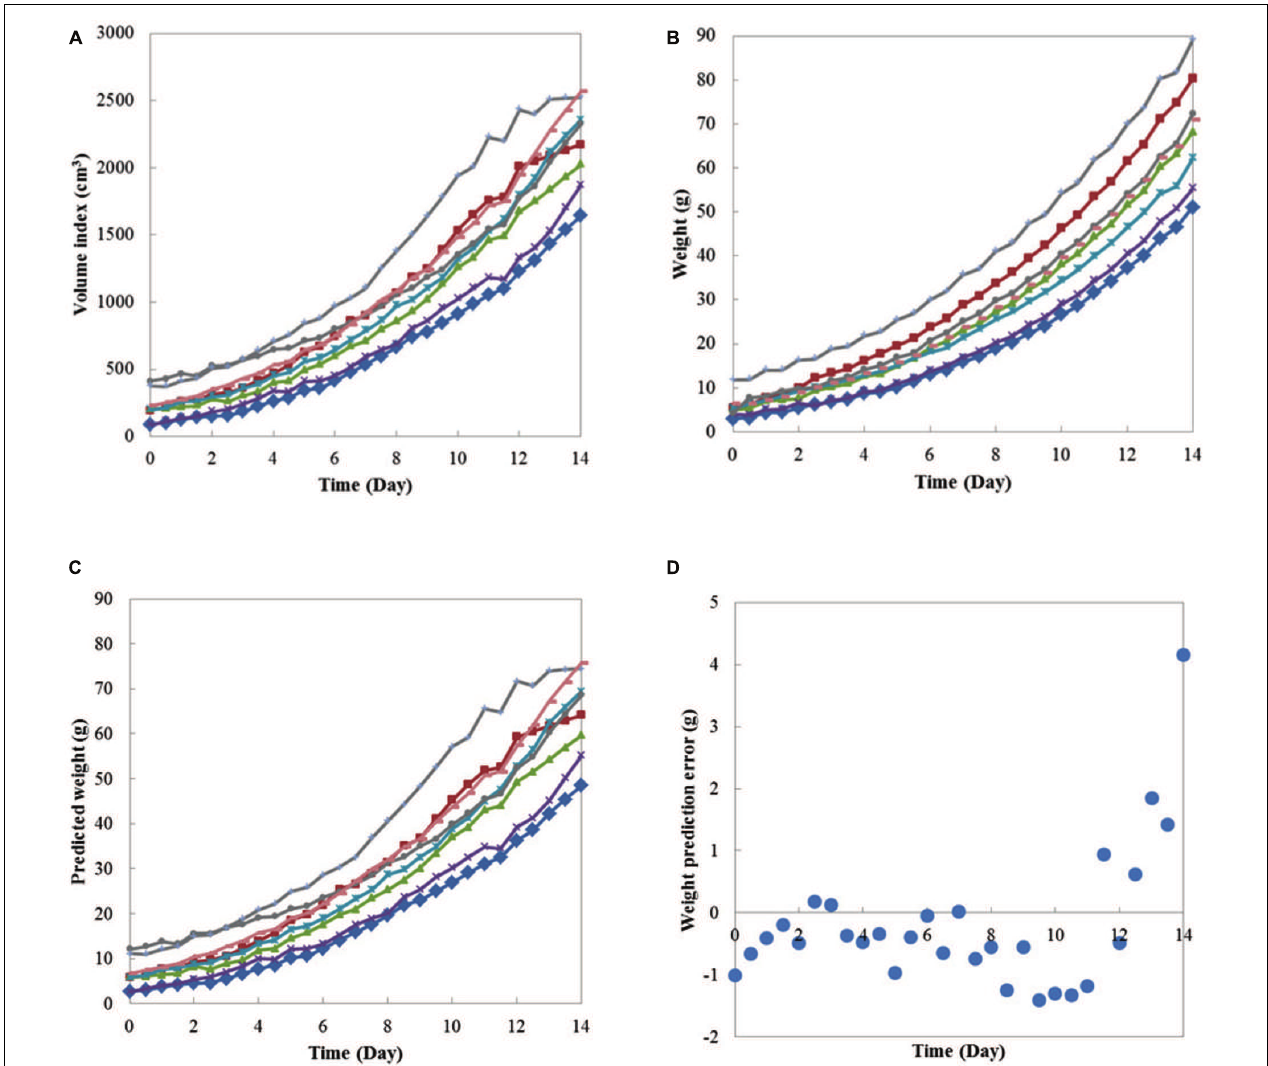
FIGURE 9 | Growth curves of eight Boston lettuces. (A) volume index measured by the imaging system; (B) weight measured by the weight measurement instrument; (C) weight predicted from the volume index measured; and (D) the prediction error over the growth period.